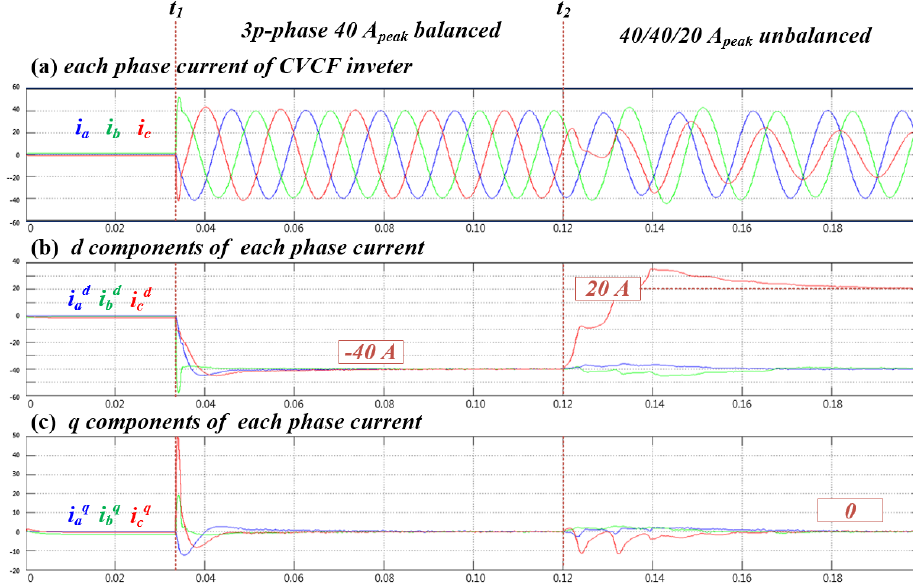
Figure 12. Performance of a single-phase power control algorithm.